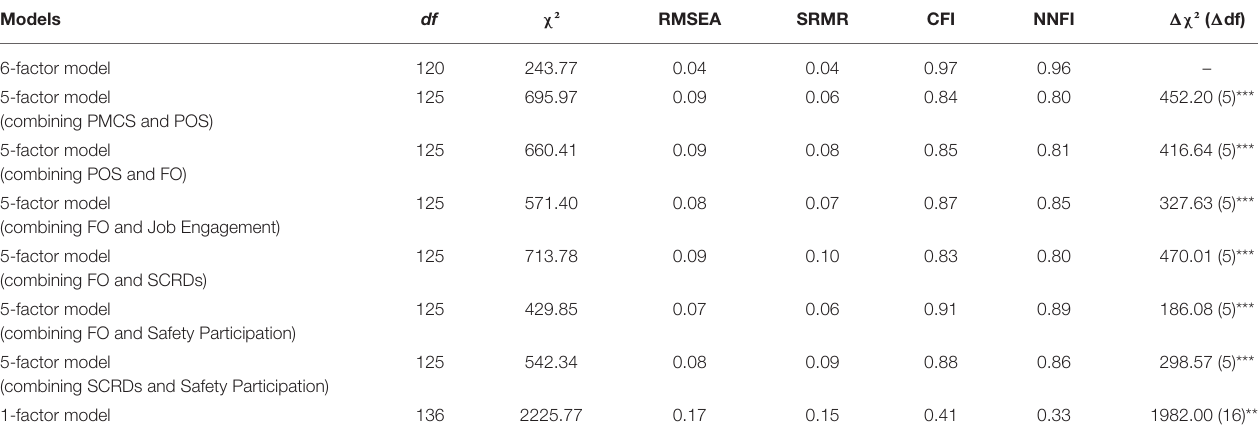
TABLE 1 | Fit indices for the measurement models. Models